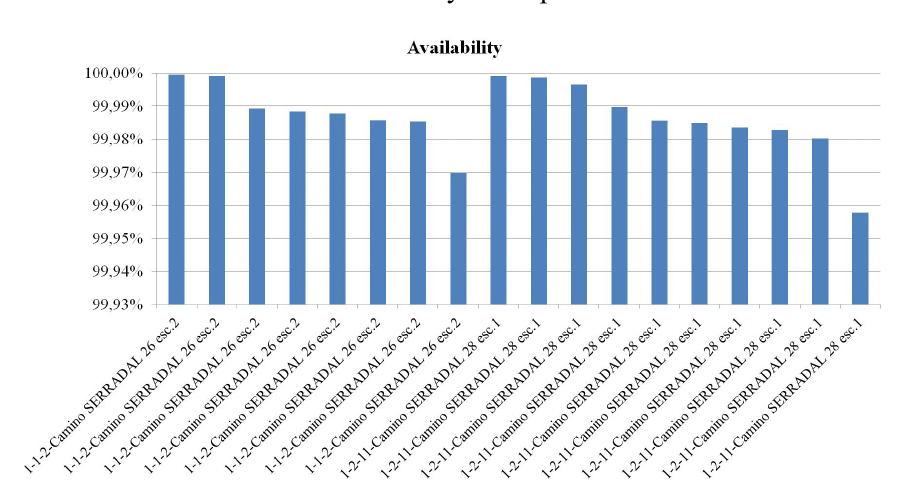
Figure 4. Sample availability concept in PRIME in a real field test subnetwork. Each bar represents one SN in the location described by the